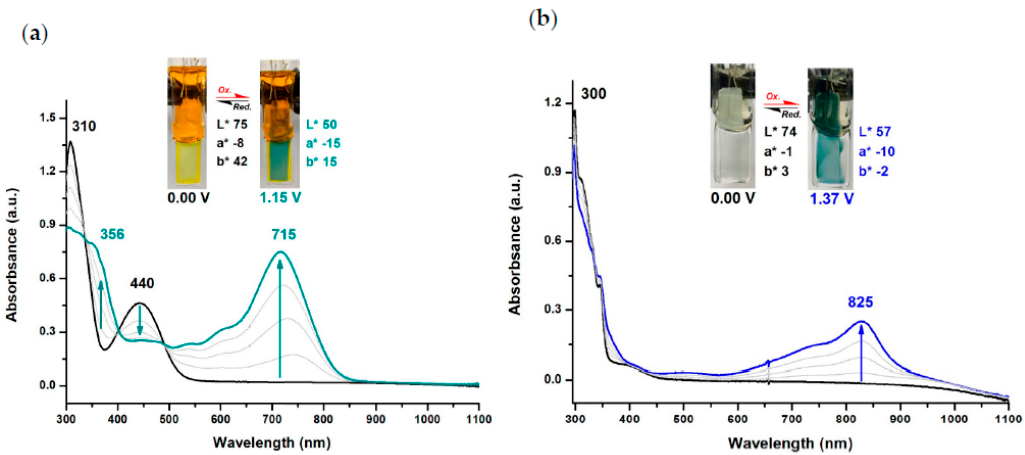
Figure 17. Spectroelectrograms and color changes of 2 mM of ( a ) M1 and ( b ) M2 in 0.1 M Bu 4 NClO 4 /CH 2 Cl 2 solution at various applied voltages.